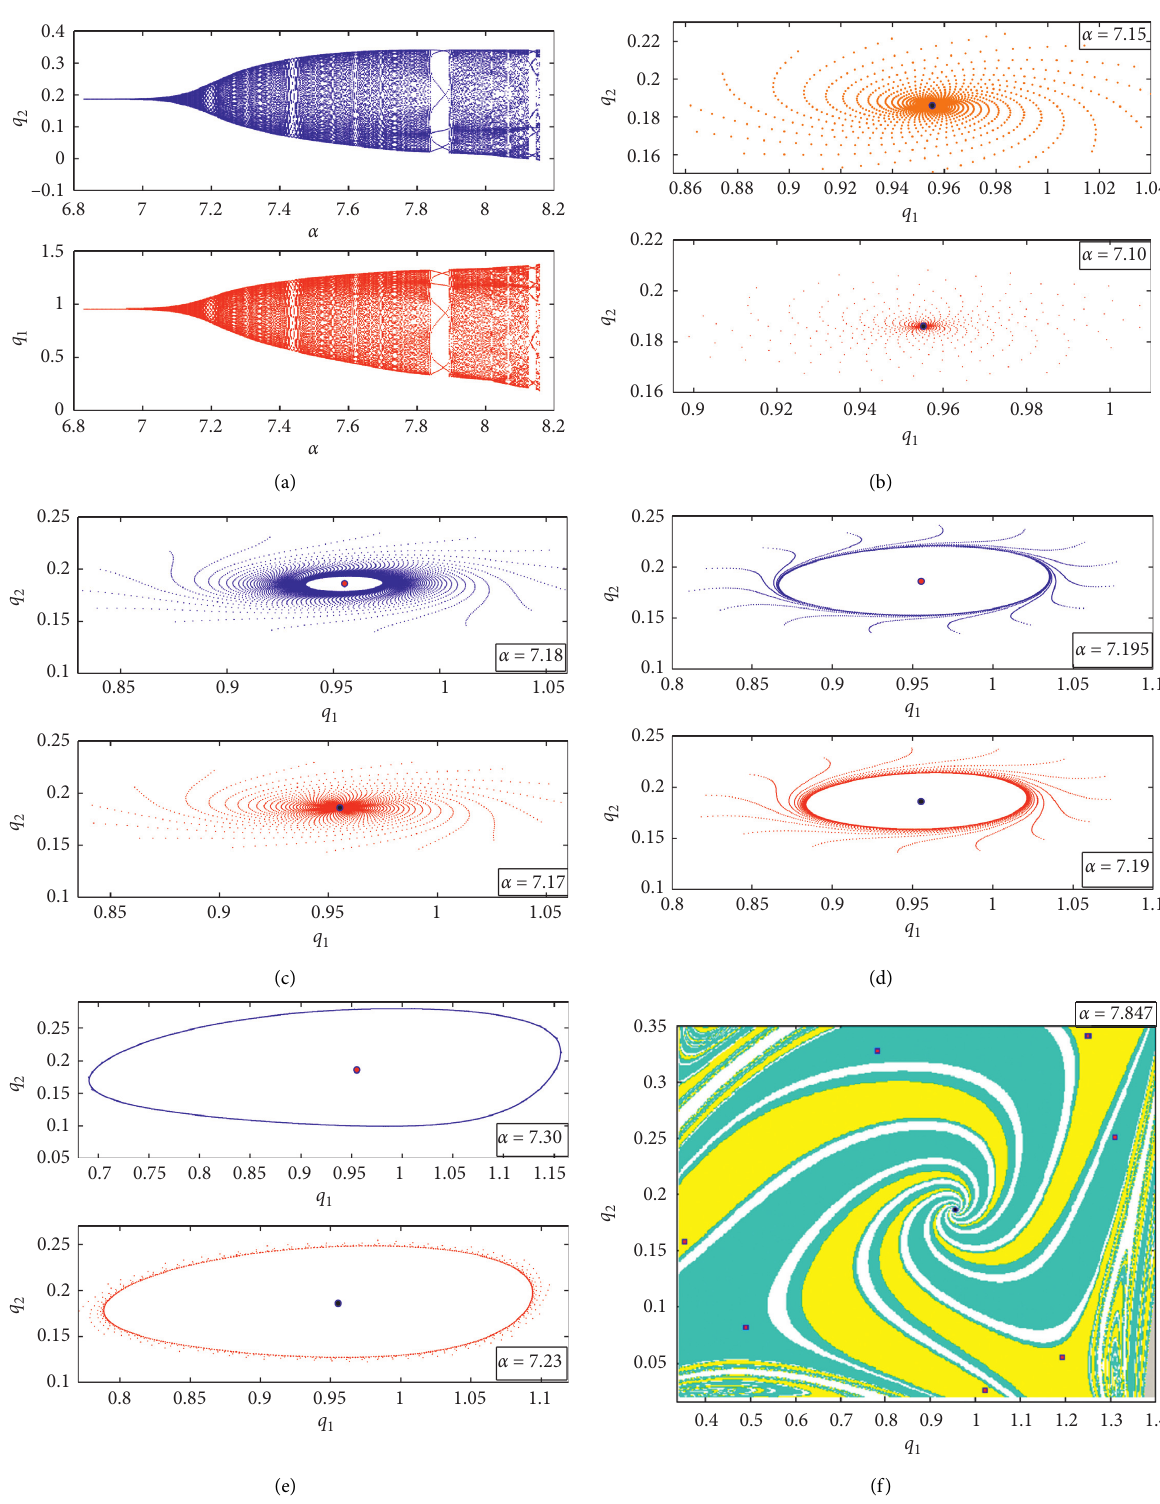
Figure 2: The fixed parameter values are c the parameter α at the initial datum (the red color) ( x stable spiral point at α � 7 . 17 and α � 7 . 18. (d) Phase plane of an invariant closed curve at α � 7 . 19 and α � 7 . 195. (e) Phase plane of an invariant closed curve at α � 7 . 23 and α � 7 . 30. (f) Stable period 7-cycle and its basin of attraction at α � 7 .